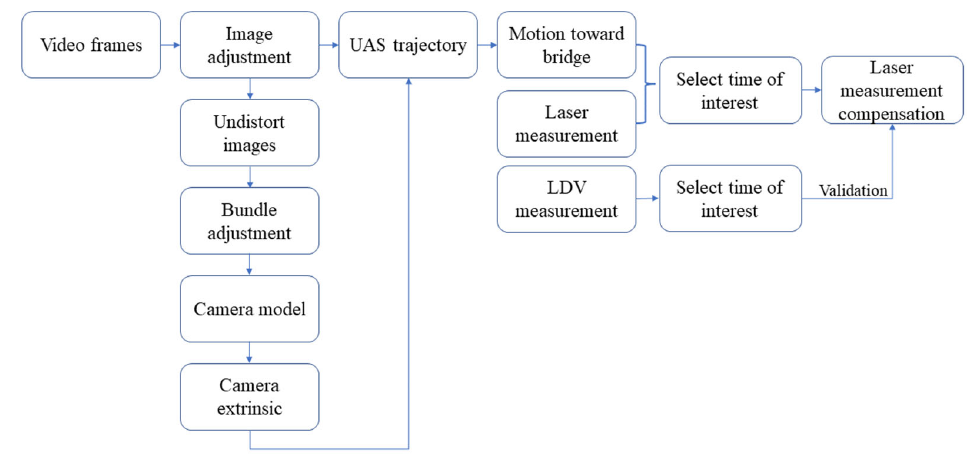
Figure 2. Flow chart of the methodology.